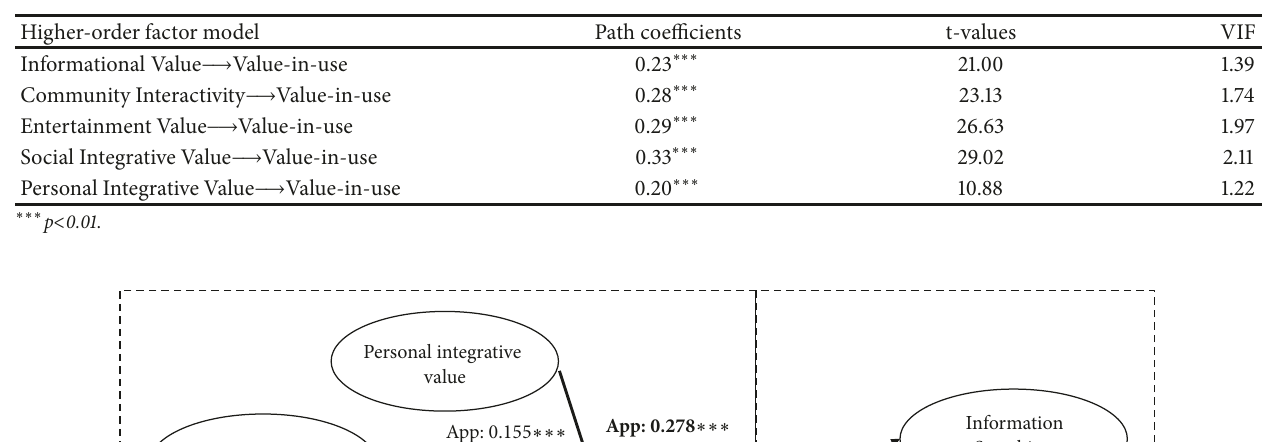
Table 4: Analysis of reliability and validity of the formative scale.